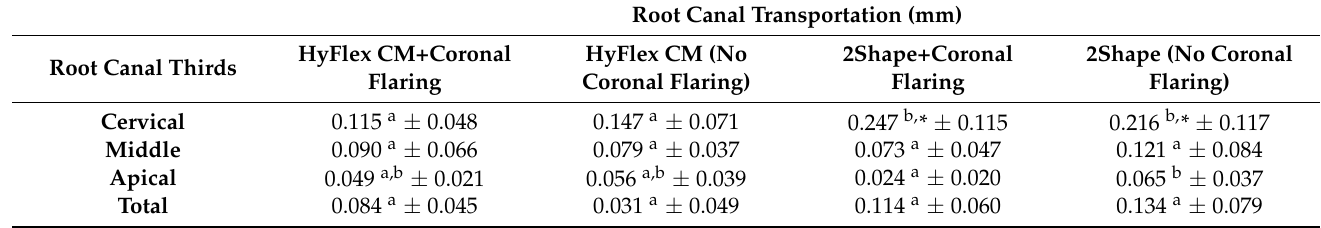
Table 1. Means (mm, millimeters) ± standard deviations of root canal transportation with the different instrumentation procedures for each root canal